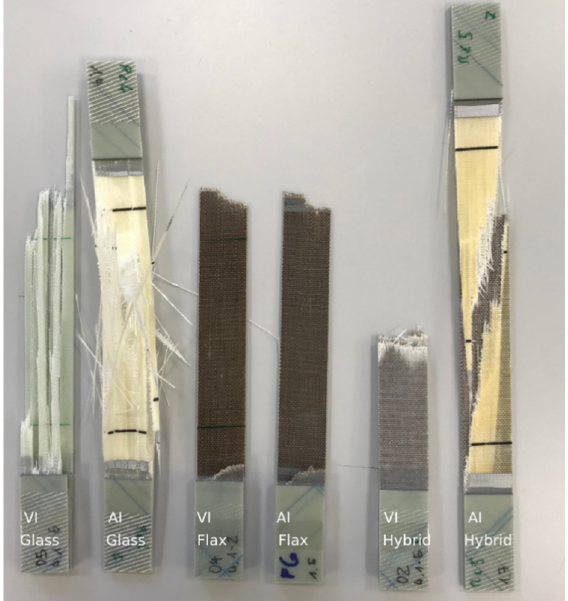
Figure 12. The appearance of fracture after tensile tests of composite laminates produced by vacuum infusion and autoclave injection (VI = vacuum infusion, AI = autoclave injection).